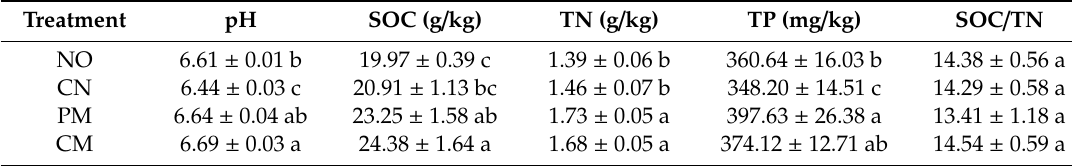
Table 3. Soil properties under di ff erent treatments.